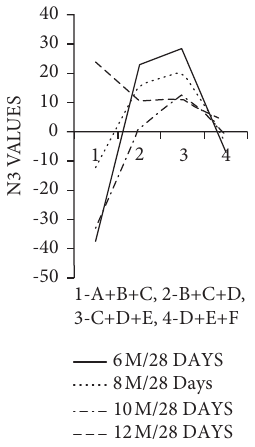
Figure 13: N3 values with increasing composition from A to F (28 days’ curing). Table 5: Trend of silica, alumina, and calcia moles and the ratios of Al/Si, Ca/Si, and Ca/(Si + Al). Combinations SiO2 mol Al2O3 mol CaO mol Al/Si Ca/Si Ca/(Si+Al) A +B+C (1) 0.87 0.24 0.22 0.28 0.25 0.20 B+C +D (2) 0.83 0.23 0.27 0.28 0.33 0.25 C +D+E (3) 0.78 0.23 0.33 0.29 0.32 D +E+F (4) 0.74 0.22